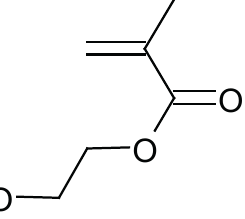
Figure 4. The schematic formula of 2hydroxyethyl methacrylate (properties: colorless liquid, density 1.07 g·cm -3 , melting point 99 o C, boiling point 213 o C, vapor pressure 0.08